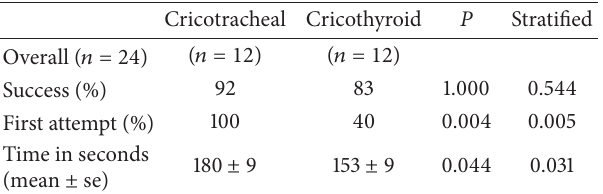
Table 1: Site differences for success, first attempt, and time to perform the